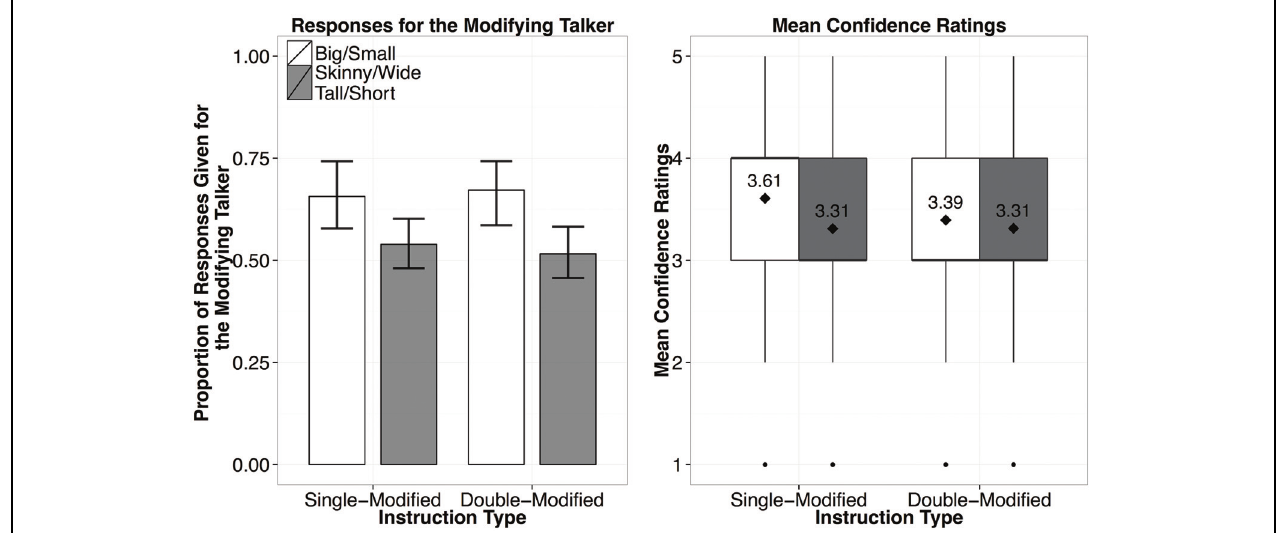
FIGURE 7 | Results from Experiment 3, showing the proportion of responses given for the modifying speaker by Instruction Type (left), and the confidence ratings for responses by Instruction Type (right; diamond dots reflect the mean rating out of